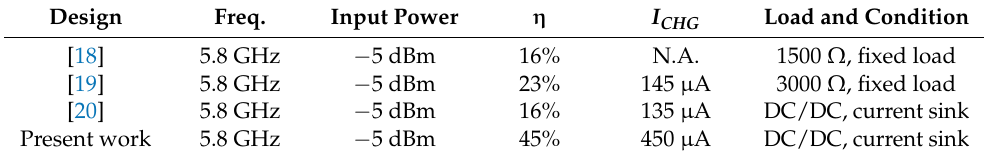
Table 3. Harvesting performances in comparison with the state-of-the-art approaches.